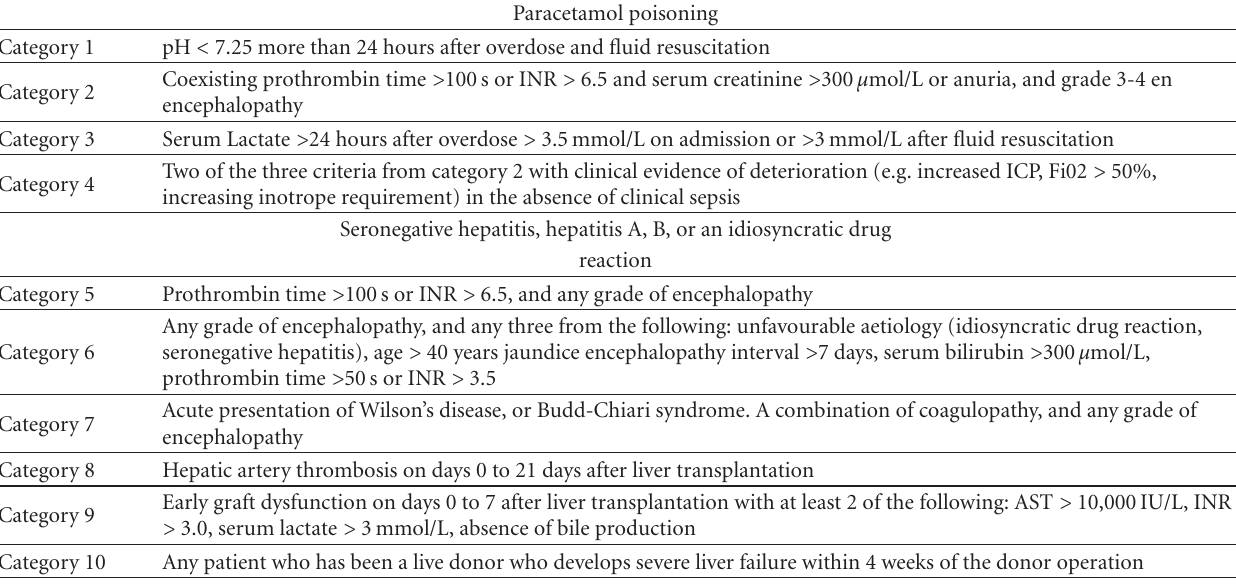
Table 4: UK blood and transplant criteria for registration as a super-urgent transplant.